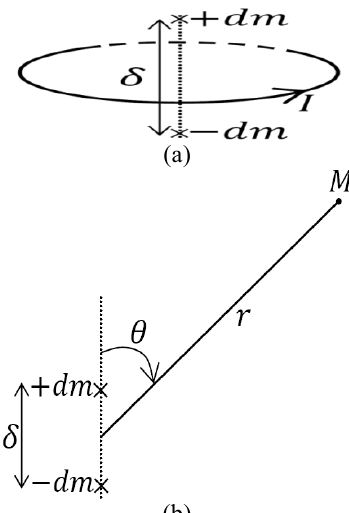
Figure 6: Definition of Ampere’s equivalent magnetic masses